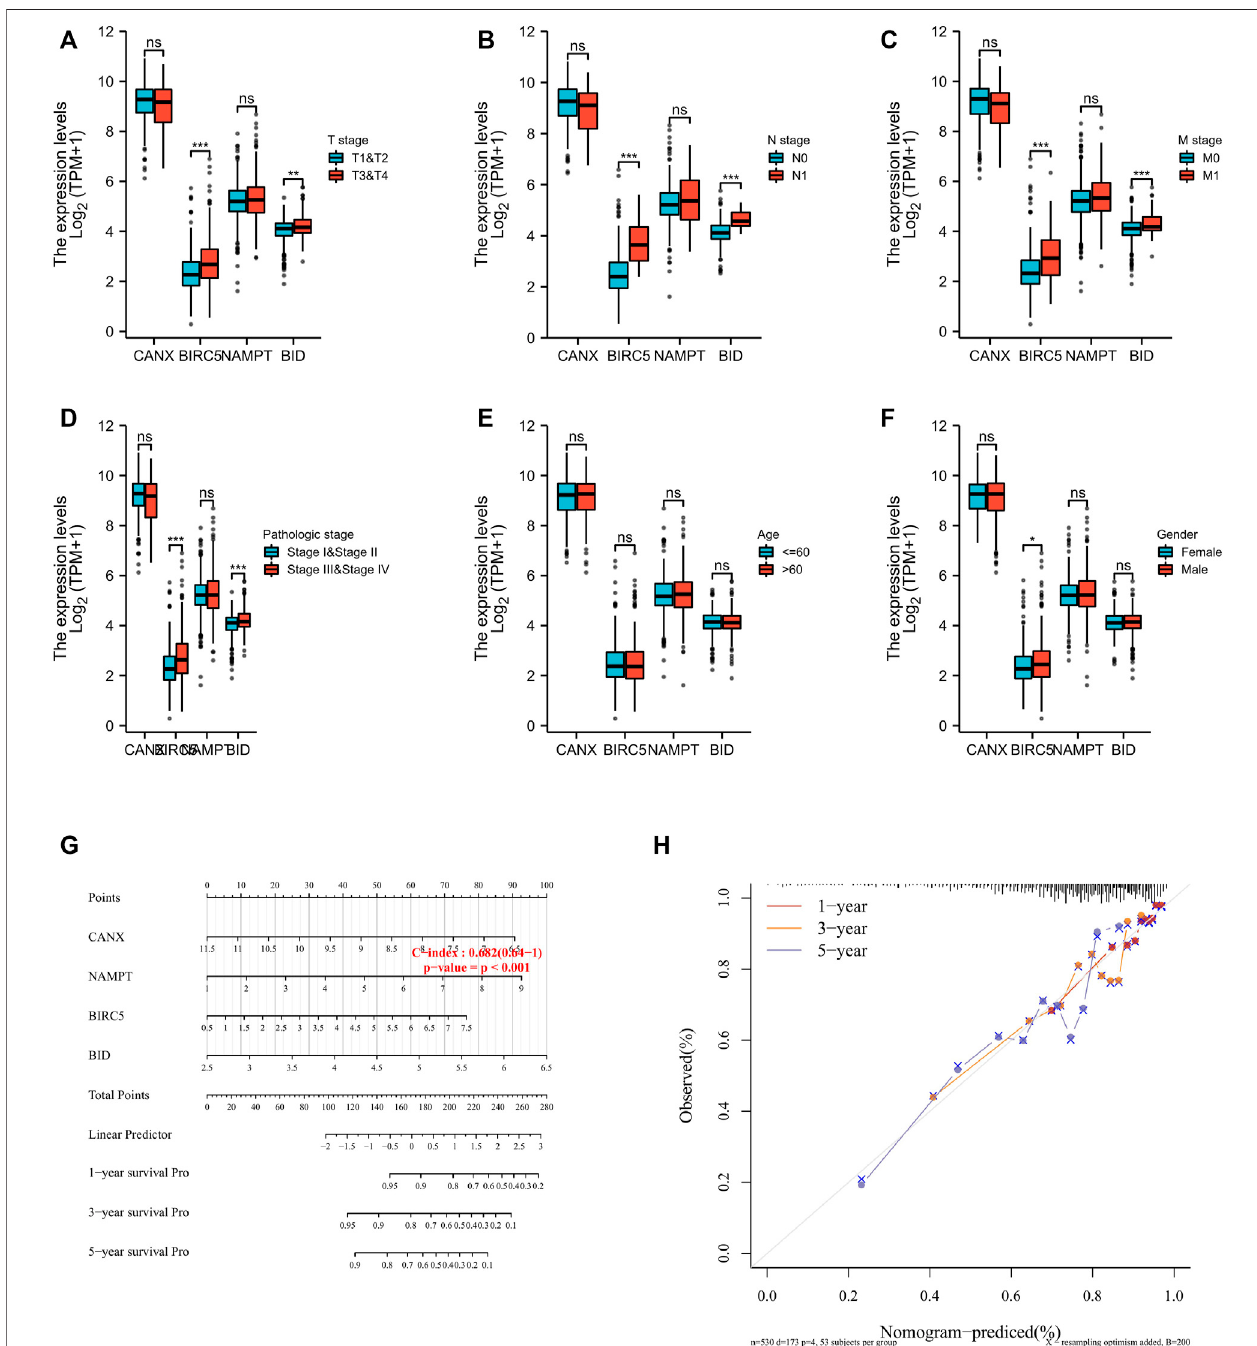
FIGURE 5 | The four immune-autophagy genes signi fi cantly correlate with multiple clinicopathological factors in kidney renal clear cell carcinoma (KIRC) patients. The relationships between CANX, BIRC5, NAMPT, and BID and clinicopathological factors in the entire The Cancer Genome Atlas (TCGA) cohort (A – F) . Nomogram for predicting 1-,3-,and 5-yearoverallsurvival(OS)in theentireTCGA cohort (G) .Calibration curvesofnomogram on consistencybetweenpredicted and observed 1-,3-, and 5-year survival in entire TCGA cohort (F) . Dashed line at 45 ° indicates a perfect prediction.